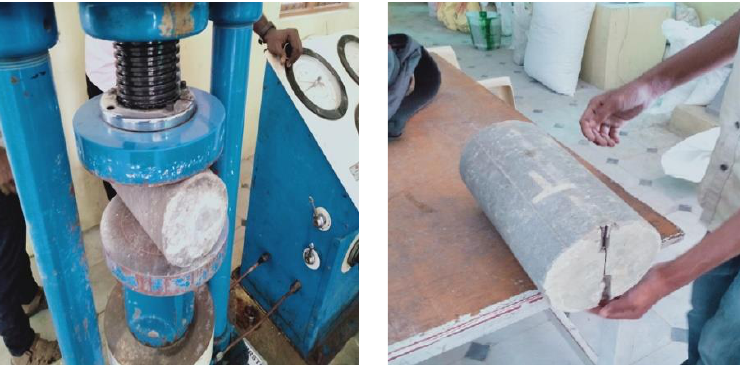
Figure 3. Split tensile strength test.